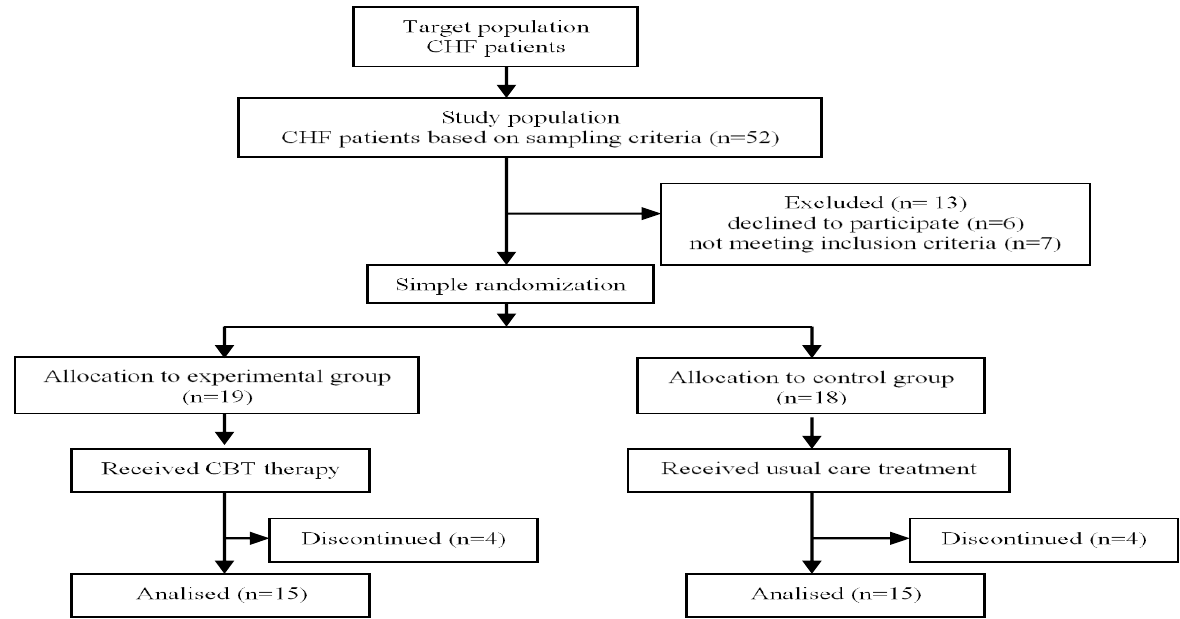
Figure 1. Research design as per the CONSORT guidelines,